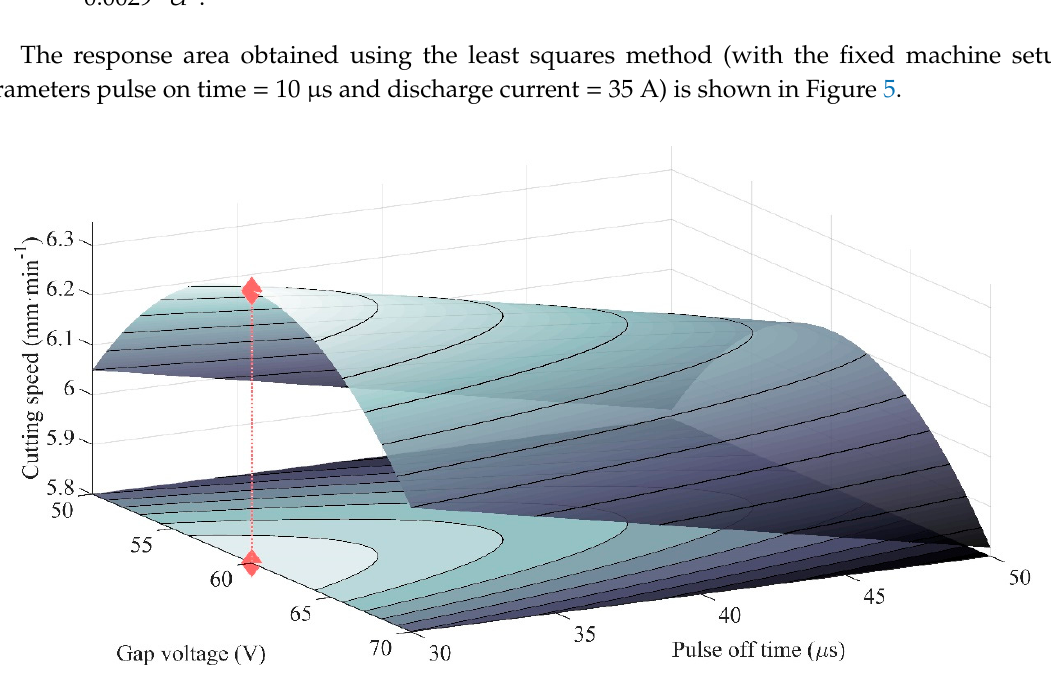
Figure 5. The response area of the cutting speed depending on the gap voltage and pulse off time with the defined optimum.